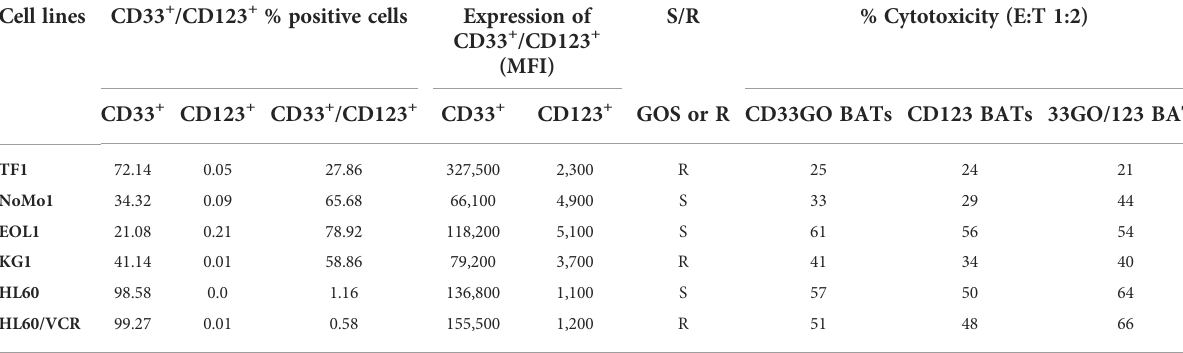
TABLE 1 Expression of CD33 + /CD123 + in cell line and cytotoxicity mediated by CD33GO or CD123 BATs. Cell